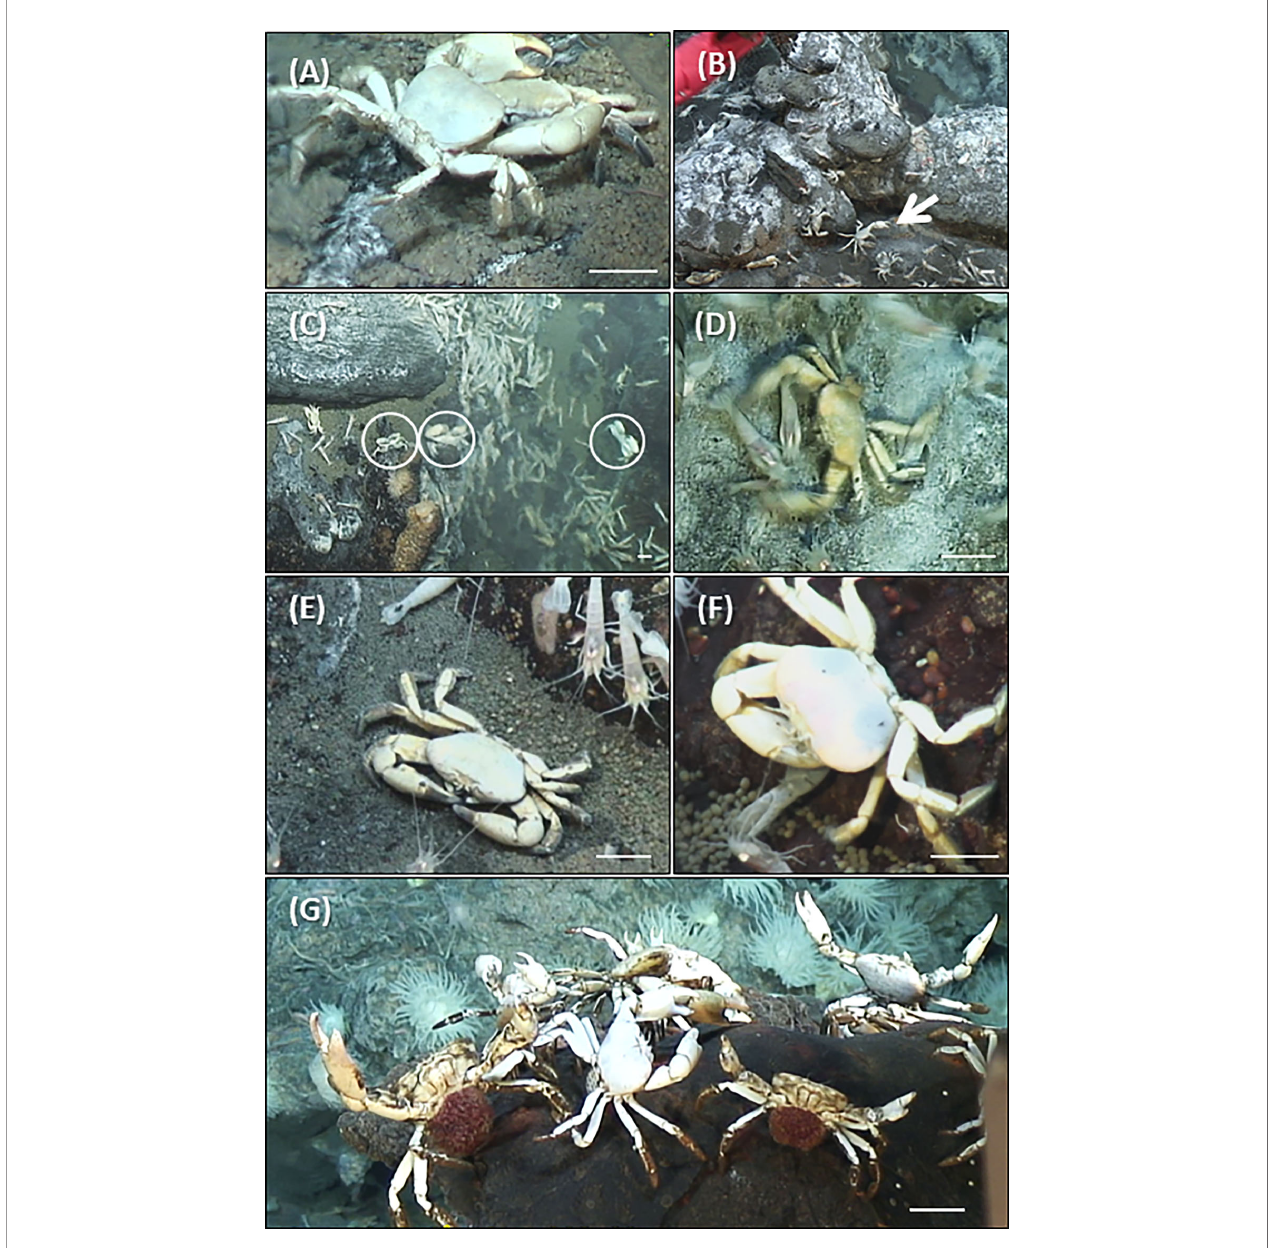
FIGURE 3 | Behavior of non-brooding and brooding crabs of Segonzacia mesatlantica close to the vent (A – F) and at the vent periphery (G) . (A) aggressive behavior, (B) territorial behavior – white arrow, (C) quietly standing – white circles, (D) predator behavior, (E, F) eating, (G) brooding behavior. Scale bar = 15